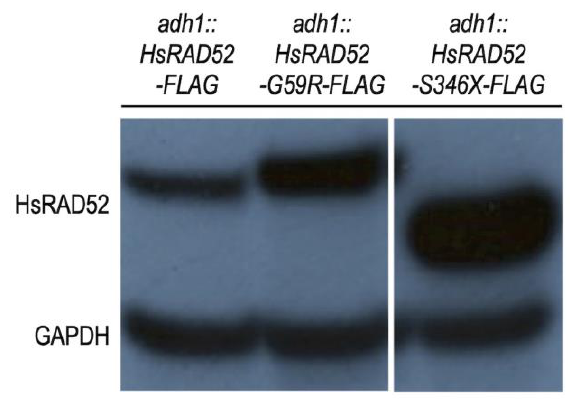
FIGURE 1: The adh1::HsRAD52-G59R-FLAG and adh1::HsRAD52- S346X-FLAG alleles express stable proteins in budding yeast cells. Whole cell extracts from strains ABX3684-12B ( adh1::HsRAD52-FLAG ), ABX3782-2D ( adh1::HsRAD52-G59R- FLAG ) and ABX3974-11C ( adh1::HsRAD52-S346X-FLAG ) were run on SDS-PAGE gels, blotted to a nylon membrane and probed with anti-FLAG and anti-GAPDH antibodies. The genotypes of the strains are denoted at the top of the figure. Bands correspond- ing to wild-type and mutant HsRAD52, and GAPDH are labeled on the left side of the